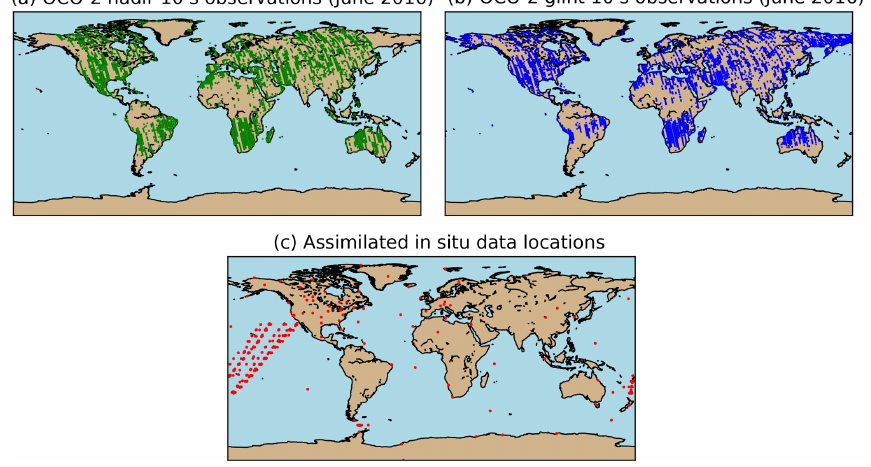
Figure 1. Sample locations of different data sources described in the text: locations of OCO-2 nadir (a) and glint (b) 10s retrievals for June 2016; in situ assimilation data (c) .